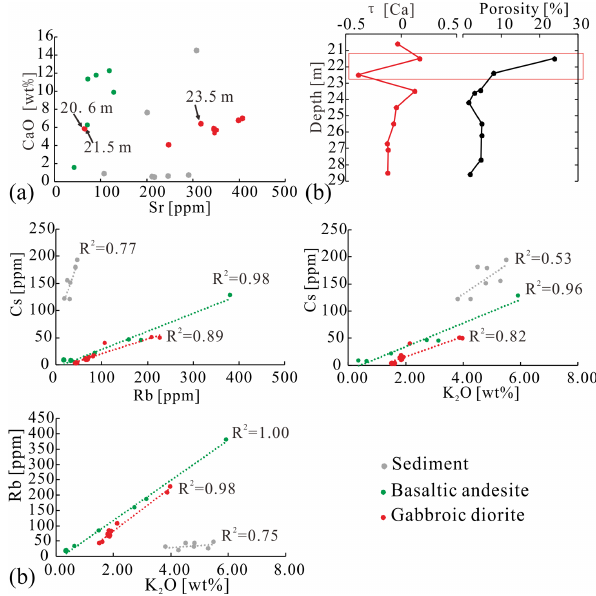
Figure 9. Element characteristics: (a) Sr–CaO cross-plot for the GA1 drill core; (b) relationship between the τ value and the poros- ity in the gabbroic diorite; (c) relationship among Rb, Cs and K 2 O for sedimentary rocks, basaltic andesite and gabbroic